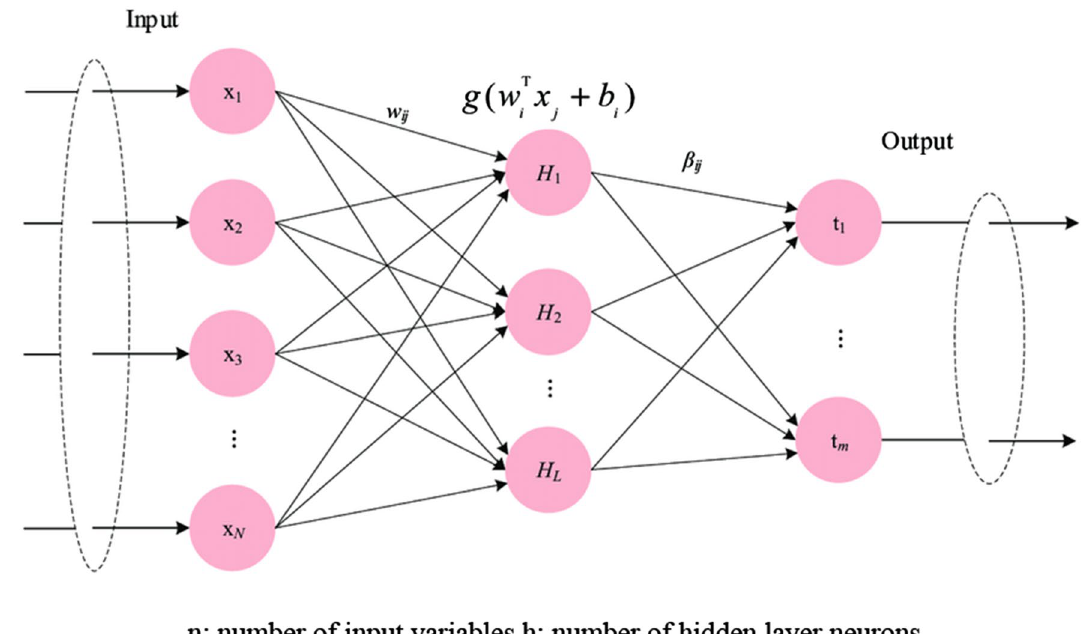
Fig. 3 SLFN network structure